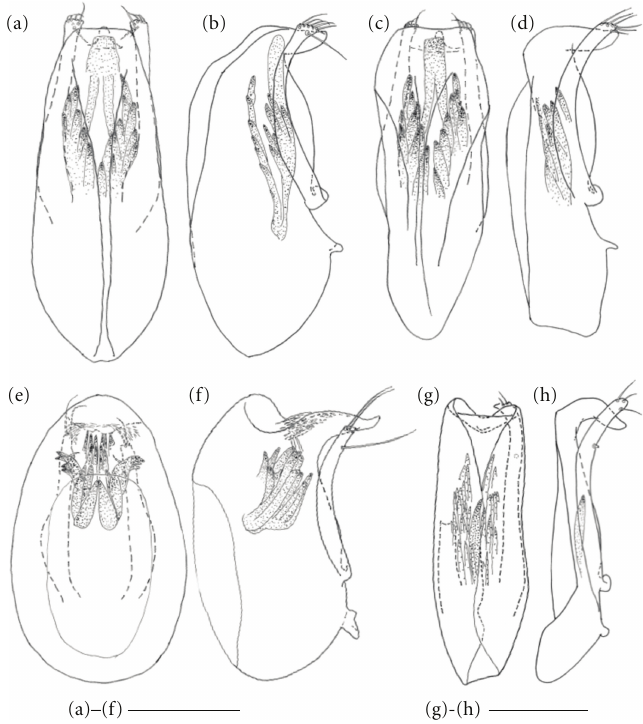
Figure 4: (a–b) Paragoniastes besucheti ((a) and (b) holotype; (c) and (d) holotype of P. parki ). (e) and (f) P. uesci (holotype). (g) and (h) P. westwoodi (holotype, feft paramere broken). Aedeagus in dorsal (a, c, e, and g) and lateral (b, d, f, and h) views. Scale bars: 0.1 mm.